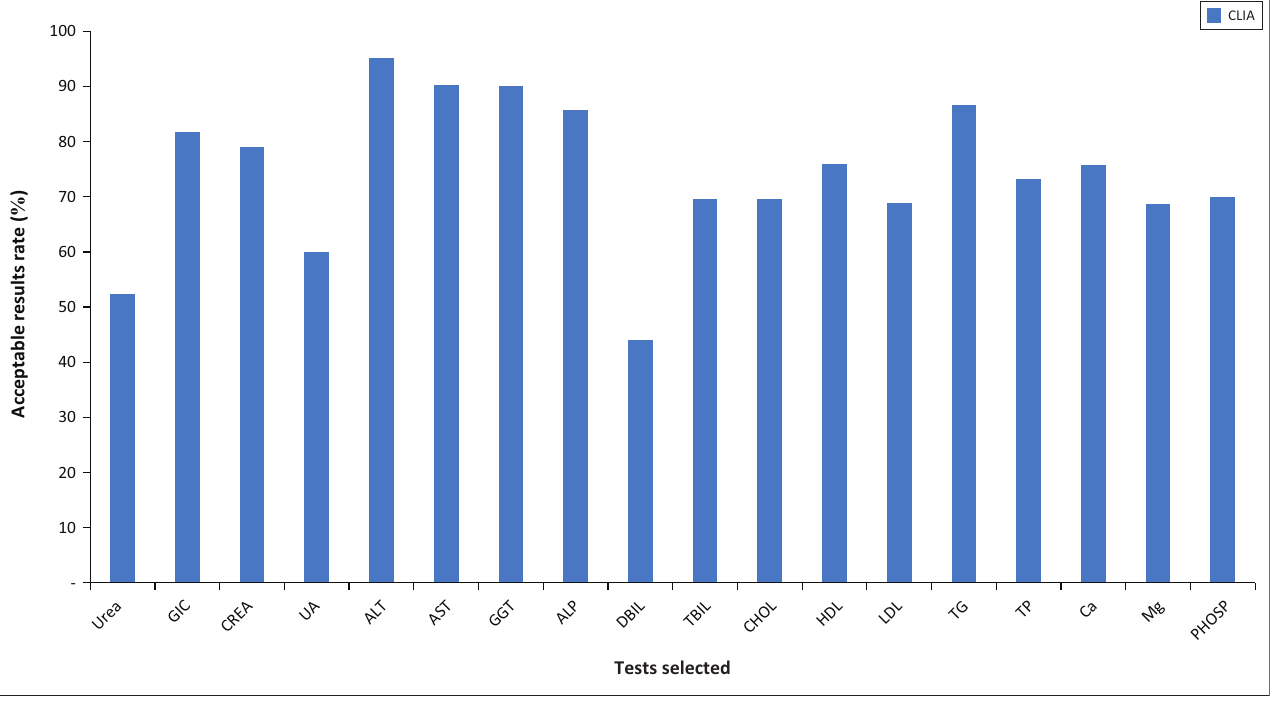
FIGURE 1: Analytical performance score of participating laboratories for each test performed in Togo from July 2016 to December